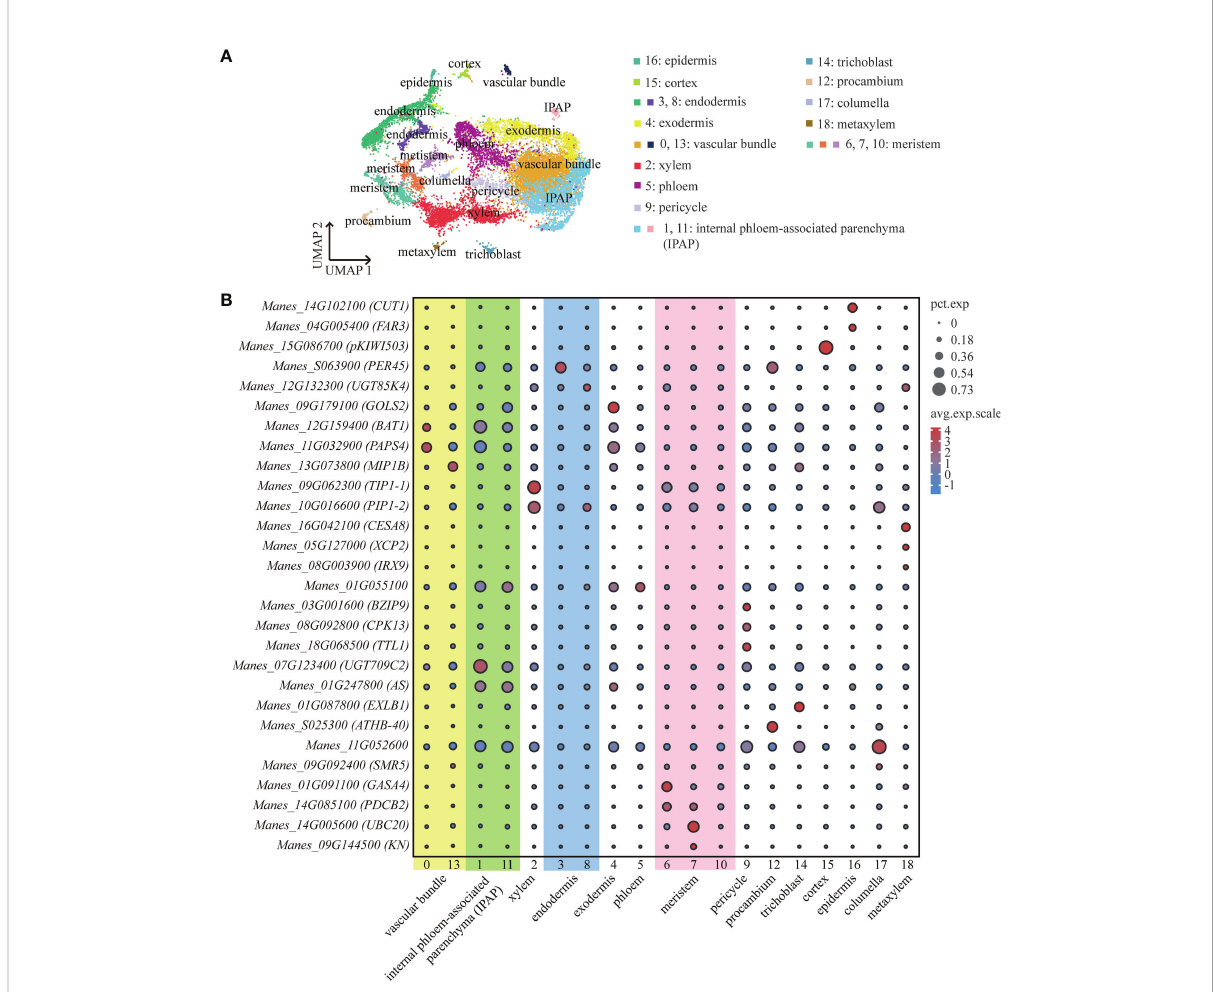
FIGURE 1 ScRNA-Seq and Identi fi cation of Cassava Cell Clusters. (A) Umap visualization of each cluster in the cassava tuberous root. Each dot indicates a single cell. Each color indicates a cell cluster. (B) Expression of genes associated with each cluster ’ s cell type. Dot size indicates the percentage of cells in the cluster that are expressing a particular gene, and color denotes expression across the cells in that cluster. PEROXIDASE 45 (PER45) was enriched in endodermis, GALACTINOL SYNTHASE 2 (GolS2) was enriched in exodermis, and 3-KETOACYL-CoA SYNTHASE 6 (CUT1) and FATTY ACYL-CoA REDUCTASE 3 (FAR3) were enriched in epidermis. CELLULOSE SYNTHASE A CATALYTIC SUBUNIT 8 (CESA8) , XYLEM CYSTEINE PEPTIDASE 2 (XCP2) and PROTEIN IRREGULAR XYLEM 9 (IRX9) were enriched in metaxylem, PROTEIN SIAMESE-RELATED 5 (SMR5) was enriched in columella, B-BOX DOMAIN PROTEIN 31 (MIP1B) , BIDIRECTIONAL AMINO-ACID TRANSPORTER 1 (BAT1) and NUCLEAR POLY(A) POLYMERASE 4 (PAPS4) were enriched in vascular bundle, CALCIUM-DEPENDENT PROTEIN KINASE 13 (CPK13) , BASIC LEUCINE ZIPPER 9 (BZIP9) and TETRATRICOPEPTIDE REPEAT THIOREDOXIN-LIKE 1 (TTL1) were enriched in pericycle, and 7-DEOXYLOGANETIC ACID GLUCOSYLTRANSFERASE (UGT709C2) and ASYMMETRIC LEAVES (AS) were enriched in internal phloem-associated parenchyma (IPAP). TONOPLAST INTRINSIC PROTEIN 1-1 (TIP1-1) and PLASMA MEMBEANE INTRINSIC PROTEIN 1-2 (PIP1-2) were enriched in